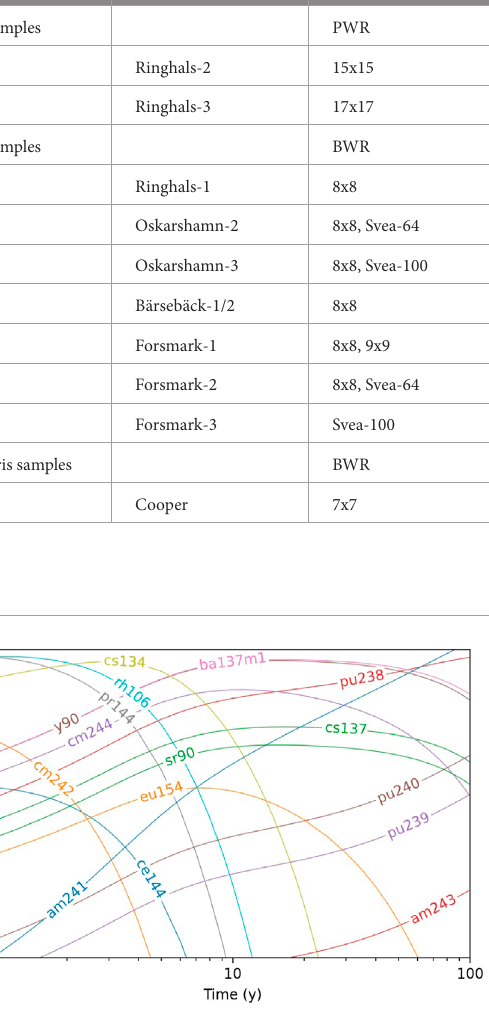
FIGURE 1 Relative contributions of the most important nuclides to total decay heat for cooling times between 1 and 100 years as obtained from an example calculation for a 16x16 PWR UO 2 fuel assembly with an initial enrichment of 4.6 wt% 235 U and a burnup of